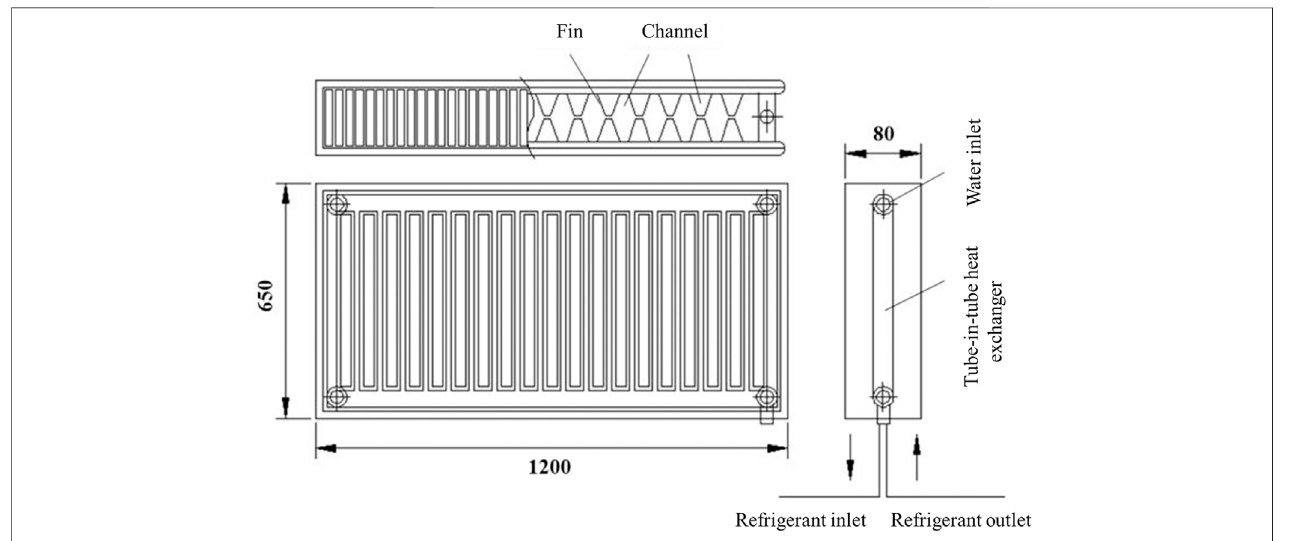
FIGURE 1 | Schematic of the proposed gravity-driven radiator (unit: mm) T: Thermocouple; P: Pressure sensor; V: Flow meter.